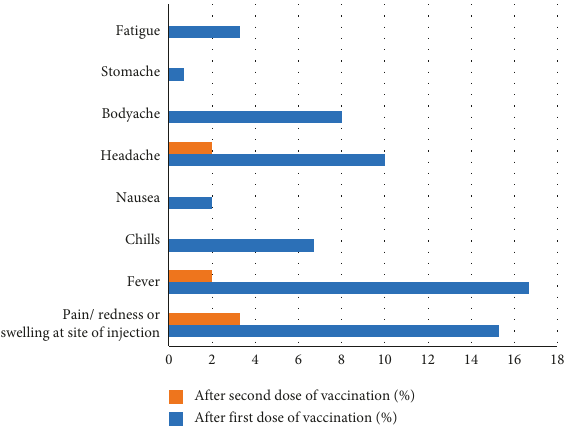
Figure 1: Adverse events reported following COVID-19